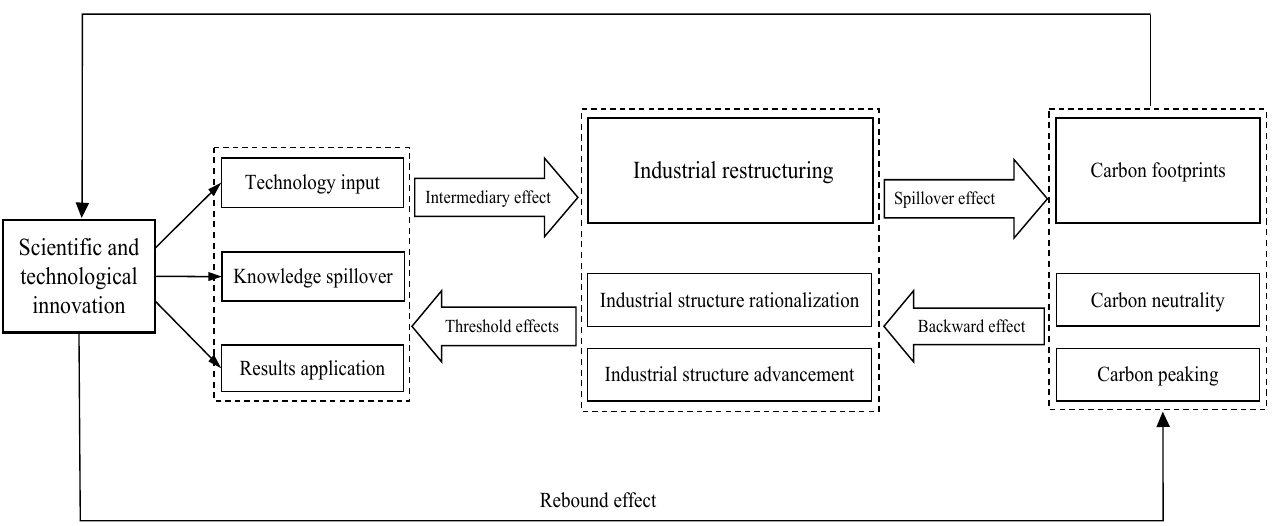
Figure 1. Relationships between scientific and technological innovation, industrial restructuring and carbon footprints. Figure source: authors’ own creation.